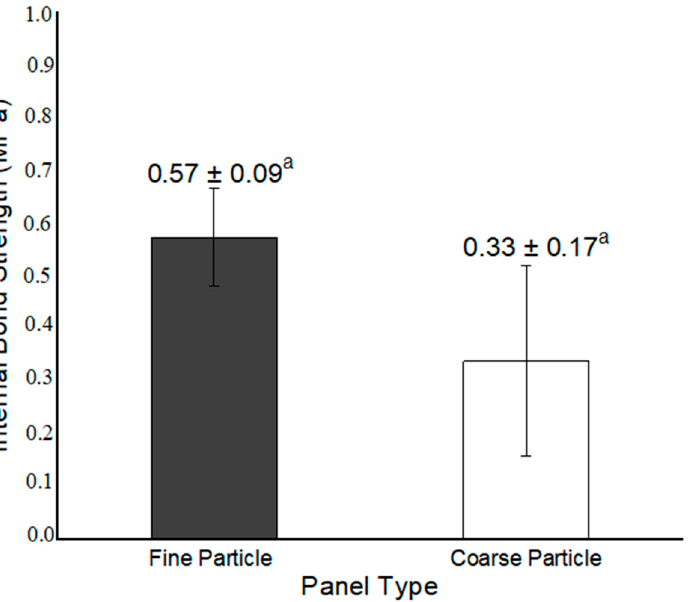
Figure 3. Internal bond strength values of the samples. Values followed by the same lowercase letters are statistically not different at p <